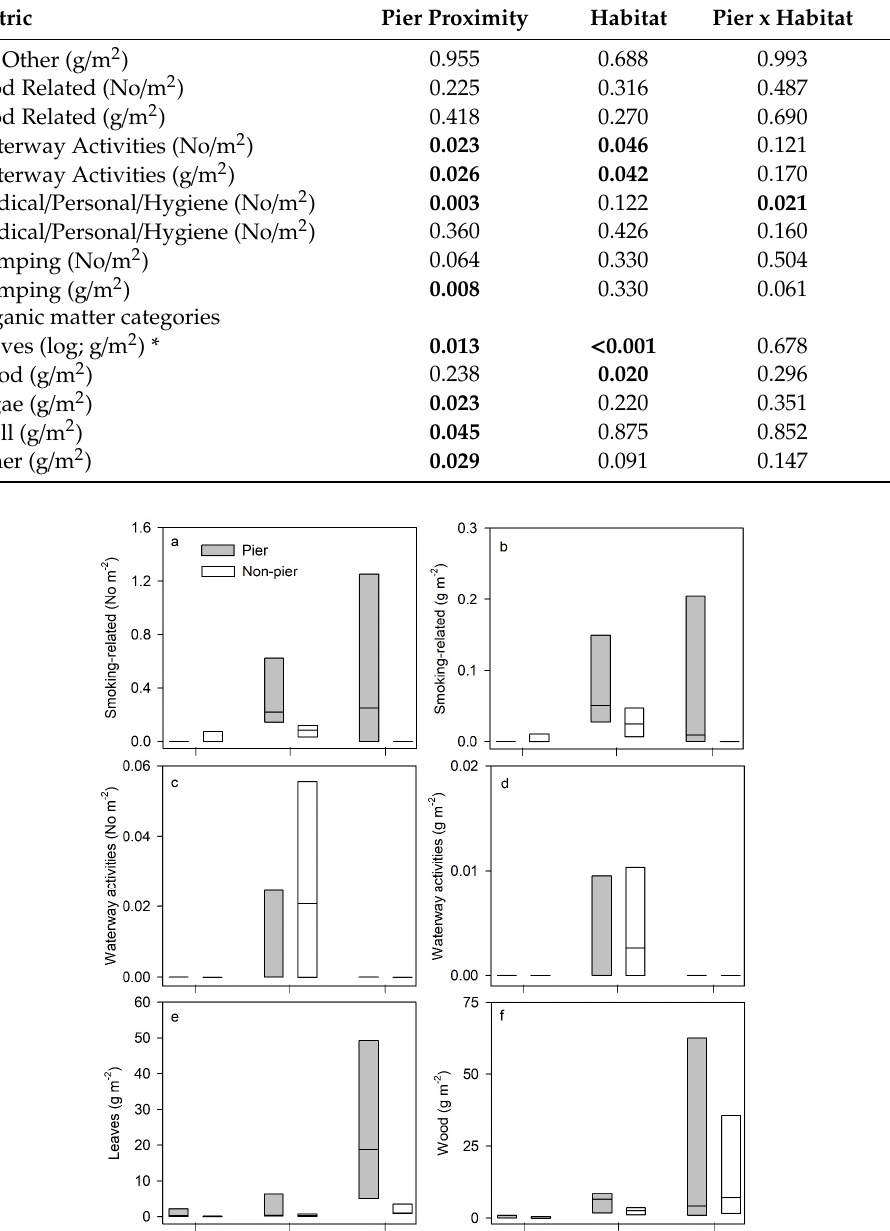
Figure 3. Median (center line) and 25th and 75th percentile (box edges) for density of litter categories at strand, beach, and upland habitats, according to pier proximity. ( a , b ): smoking-related litter, ( c , d ) litter from waterway activities, ( e ) leaves, ( f ) wood.